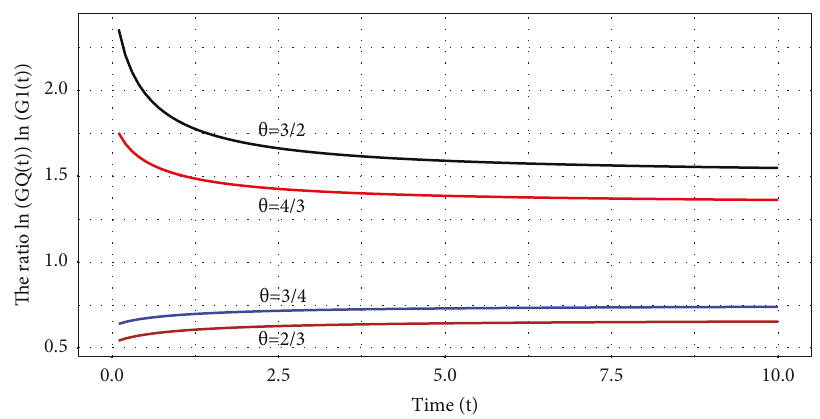
Figure 1: The plot of the function ln ( G